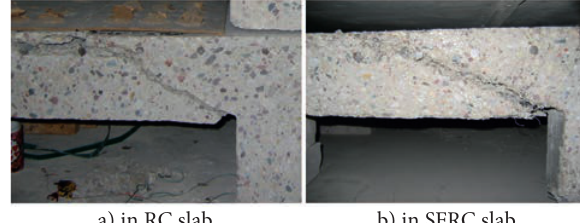
conea) in RC slab b) in SFRC Fig. 9. Formation of slab punching